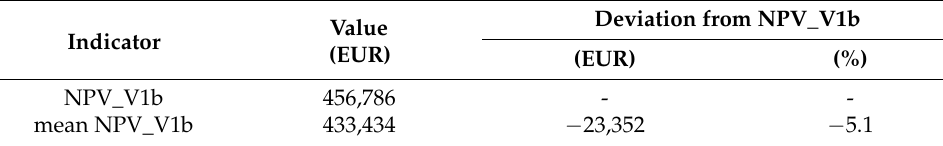
Figure 11. Tornado chart NPV_V1b. Table 9. Comparison of NPV_V1b and mean NPV_V1b